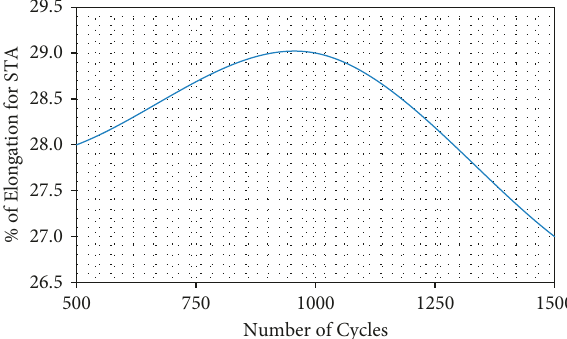
Figure 15: % of elongation of